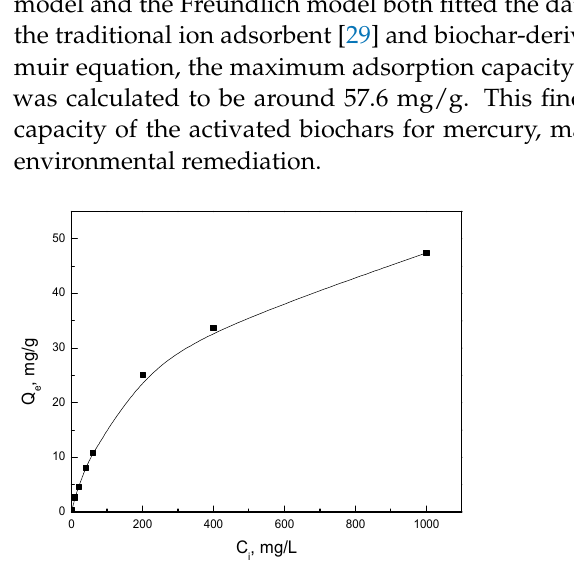
Figure 6. Mercury removal rate of activated biochars in different pH environments.